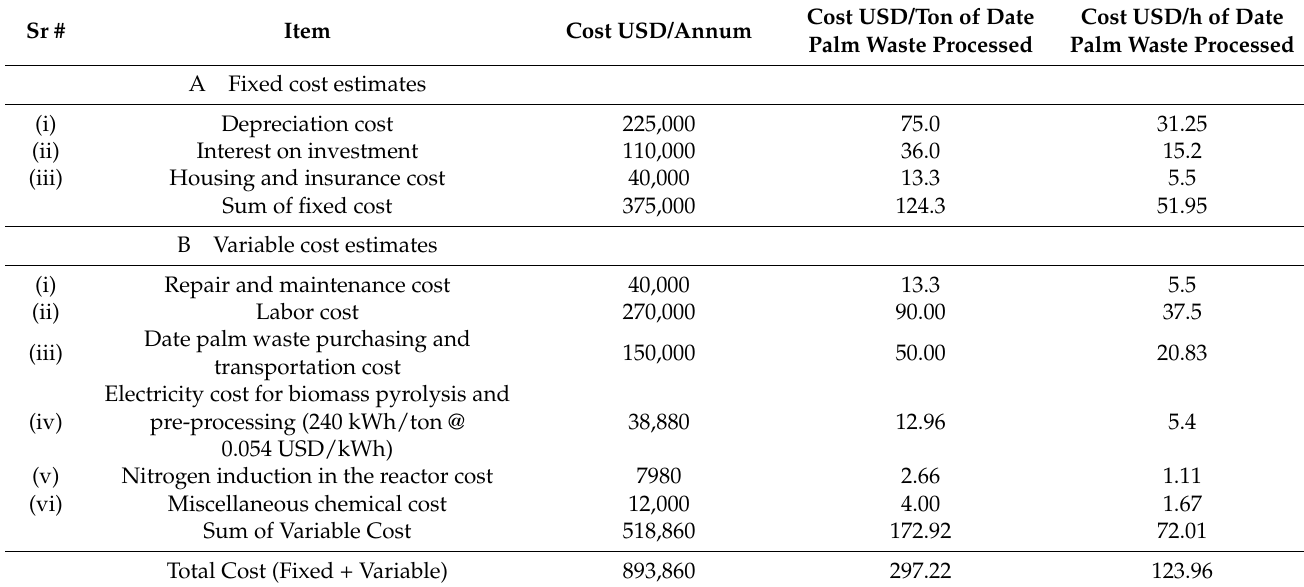
Table 7. Cost analysis of biomass pyrolysis unit having capacity of 10 tons per day.